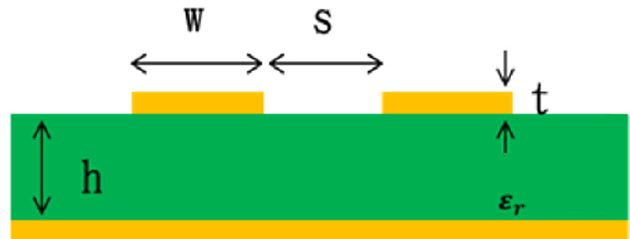
Figure 3. Side view of a transmission line on a PCB.